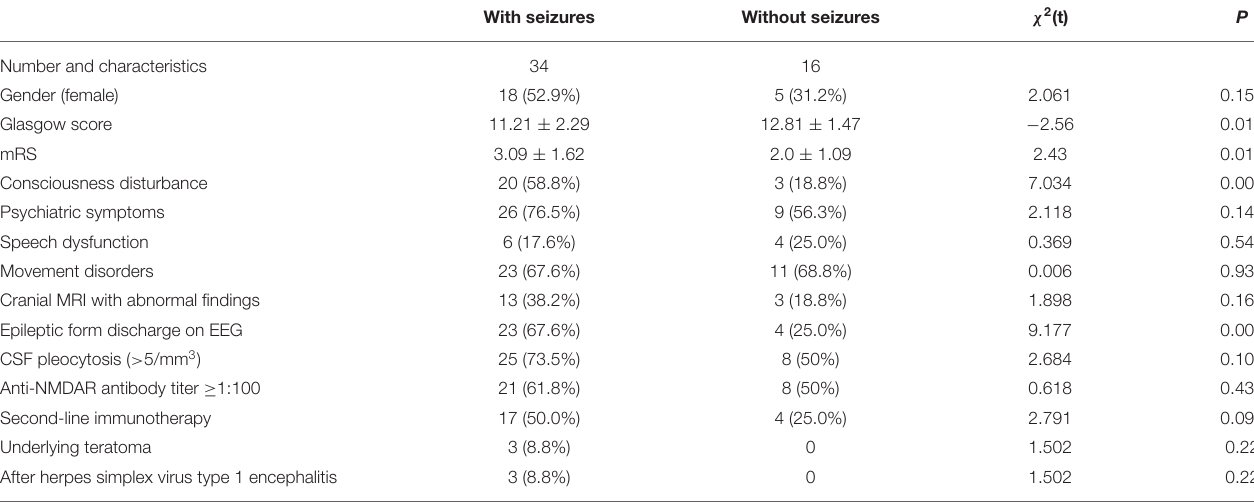
TABLE 2 | Analysis of clinical features of seizure between the three groups.